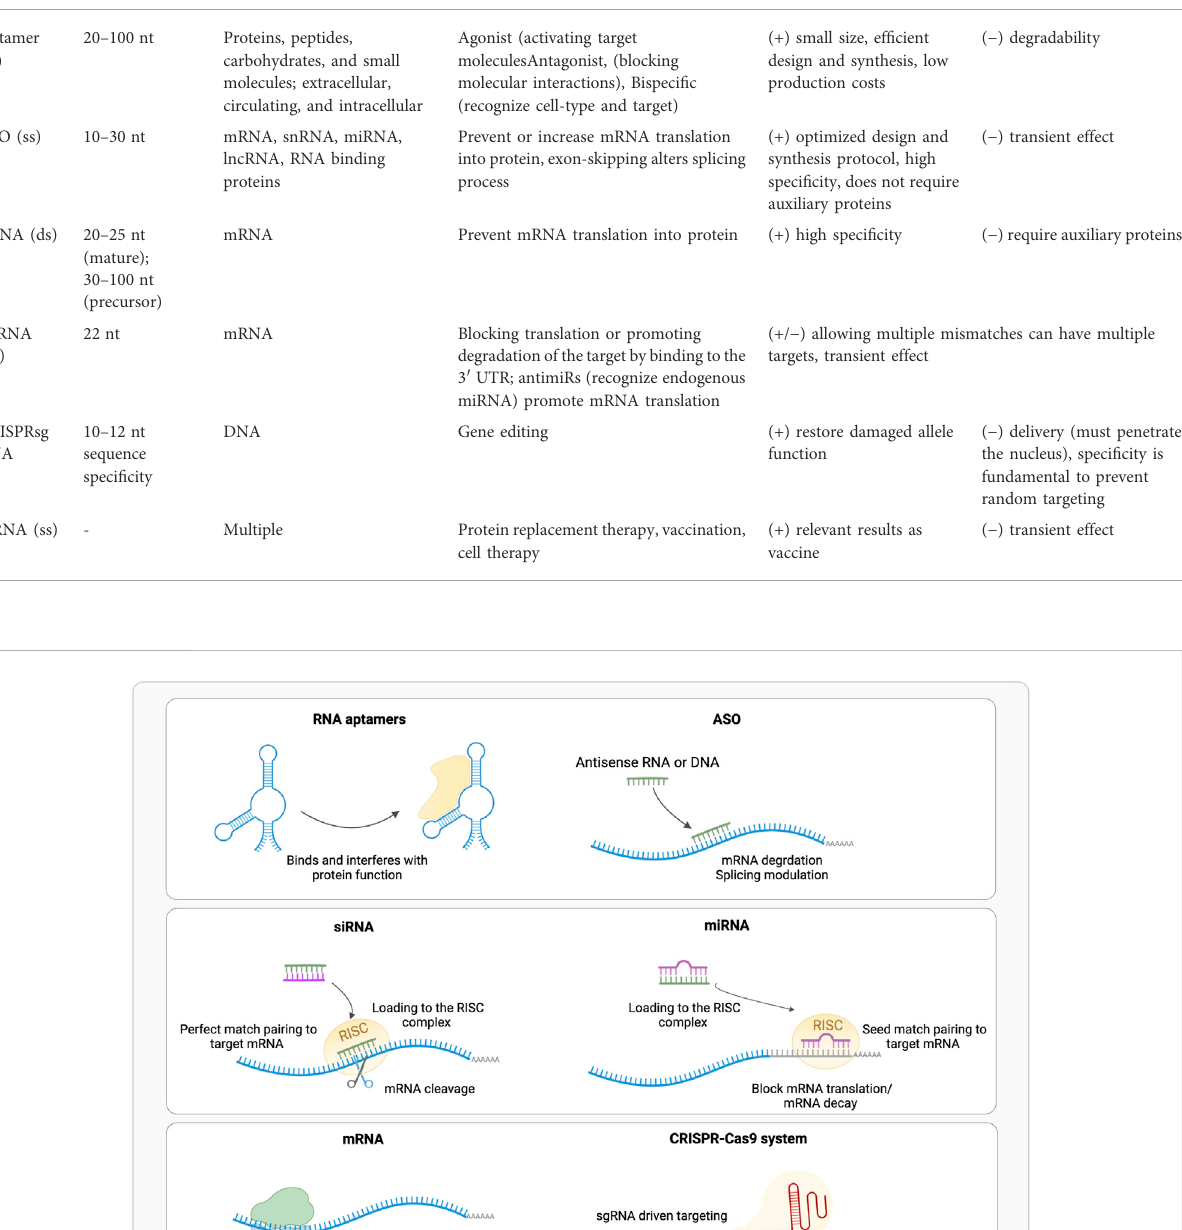
Frontiers in Molecular